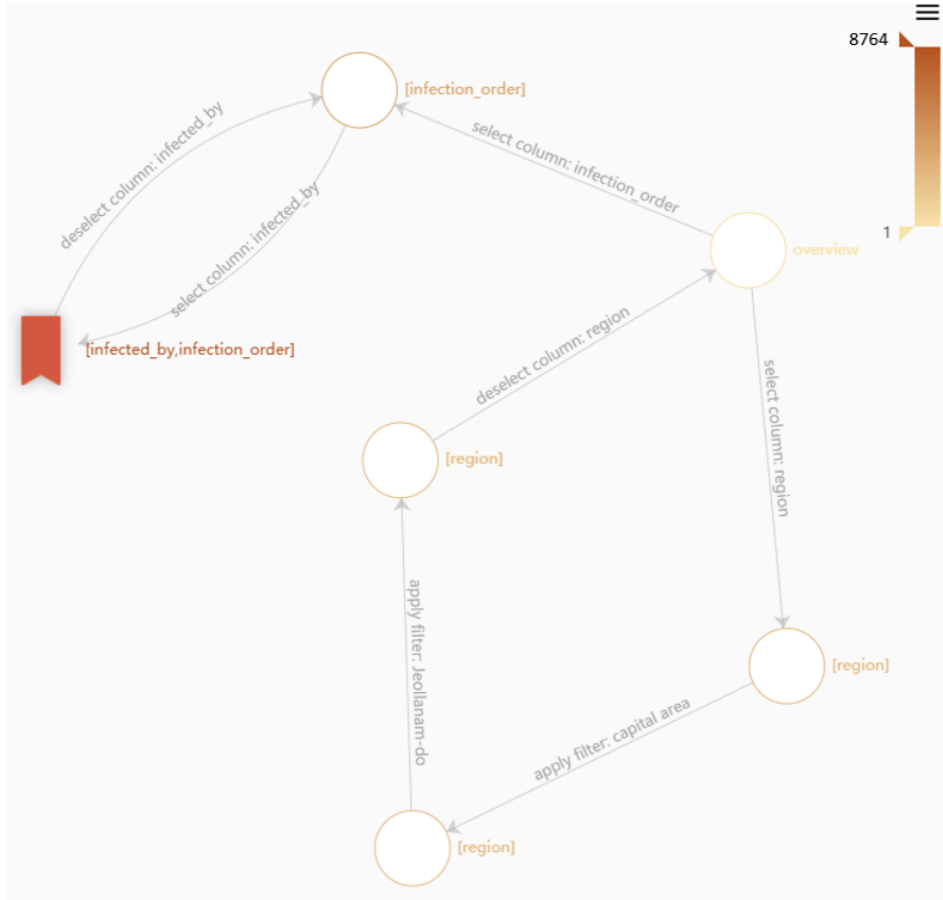
Figure 5. An example of an interaction graph that is stored in the interaction storage from the results of an EDA. The initial meta state is filtered out, since the graph only contains one session. Each node describes the state of the presented visualization (chart type, selected features, filters, etc.). Each link describes an analysis action (e.g., select a feature). Bookmarks were created by the data scientist and mark the corresponding view as containing some form of insight. A heat-map overlay shows time spent exploring the particular